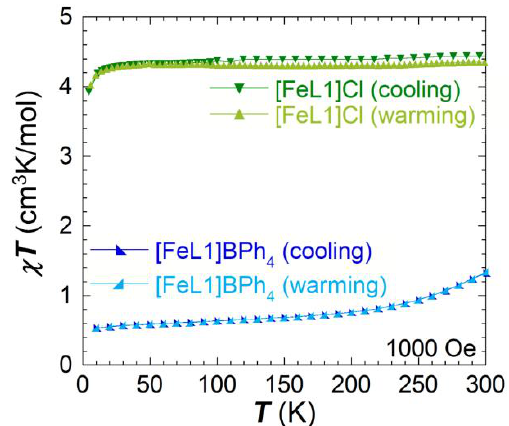
Figure 6. Plots of χ M T versus T for complexes 1 (green) and 2 (blue) between 5–300 K in cooling and warming mode.